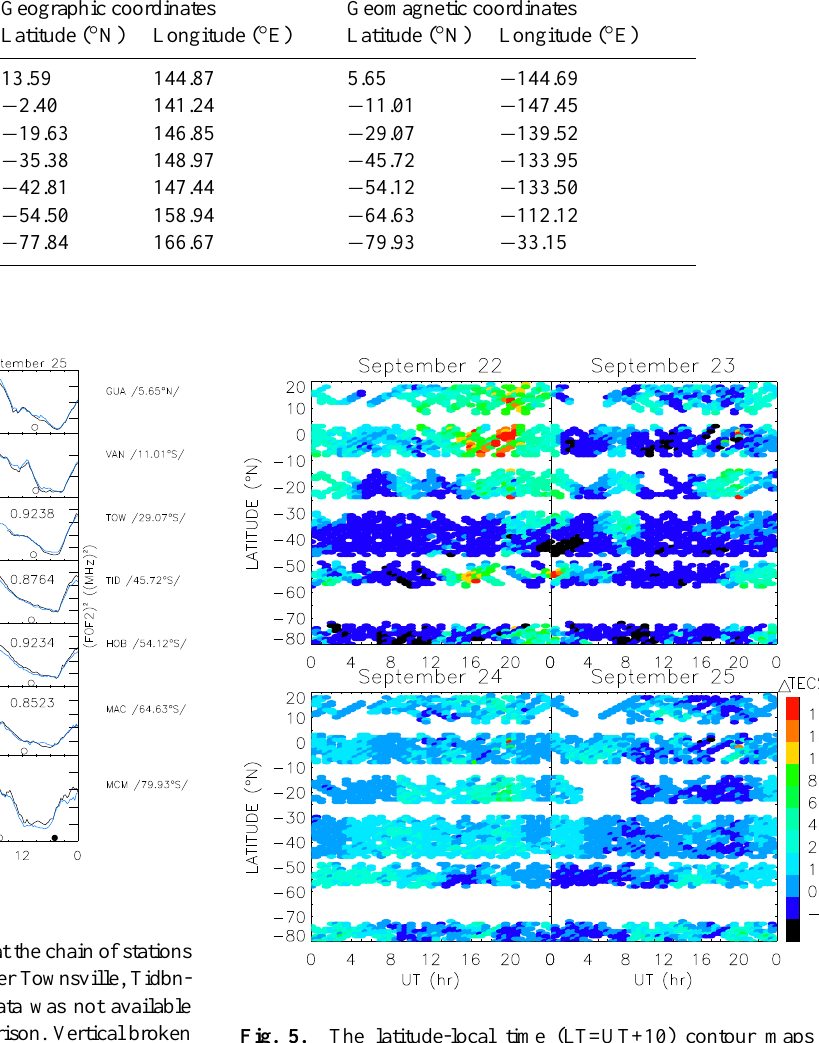
Fig. 5. The latitude-local time (LT=UT+10) contour maps of 1T EC % during the first day of the storm (left top), the second day of the storm (right top), the third day of the storm (left bottom) and the fourth day of the storm (right